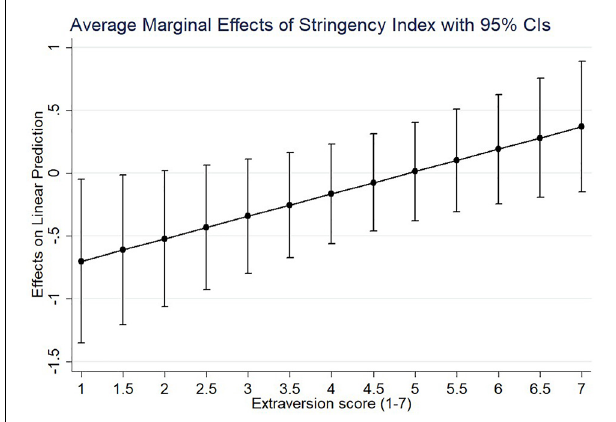
FIGURE 2 | Visualization of extraversion moderating the relation between stringency measures and depressive symptoms. CI, confidence interval. Based on Estimations in Table 4 , Model